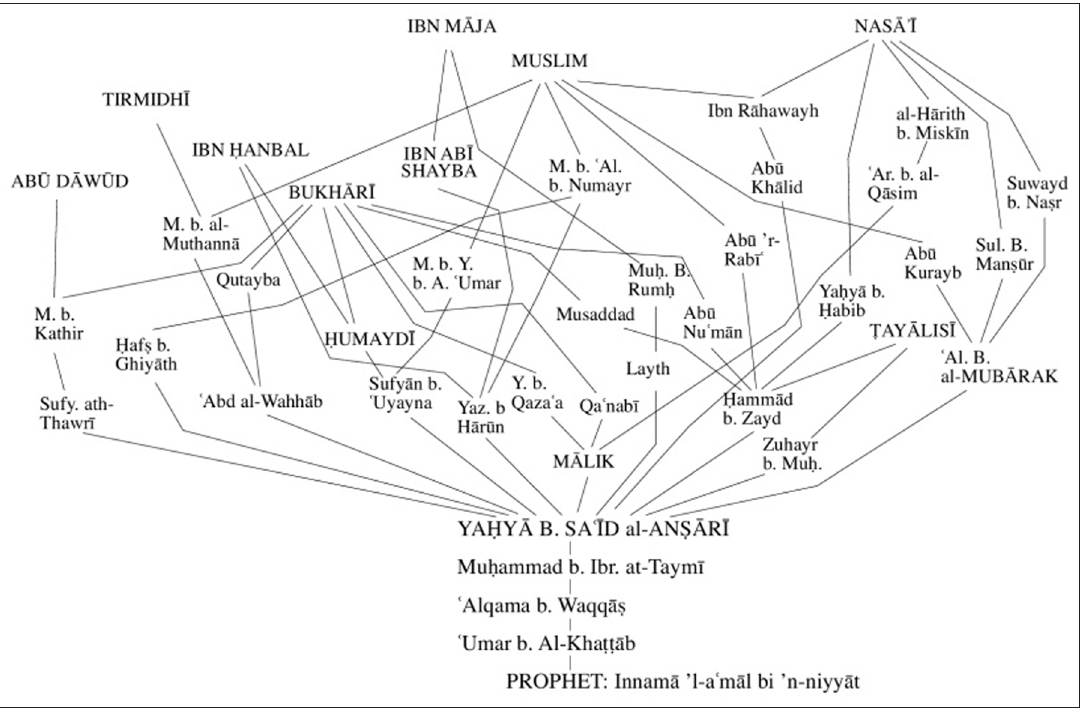
Figure 1: An isnad , meaning a “chain of human reporters,” describing who had passed a source down to whom. From G. H. A. Juynboll, Encyclopedia of Canonical Hadith (Leiden, NL: Brill, 2007), xxi. Courtesy of Brill period of time. But the net result was that it slowly became accepted that the Earth is older than 6000 years and the Bible is not reliable as a historical source. 20